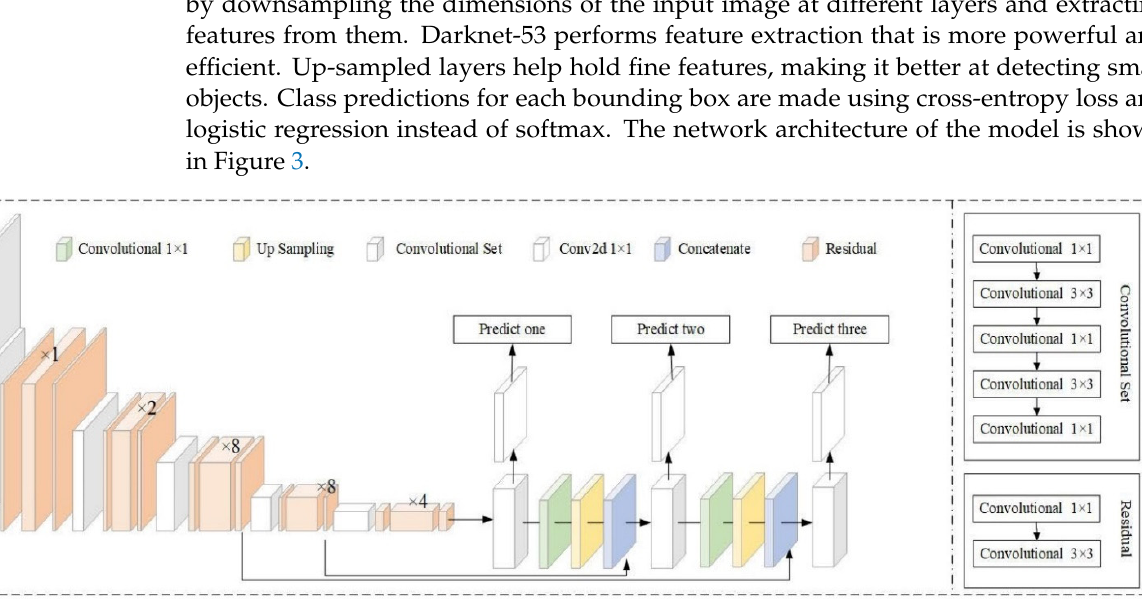
Figure 3. YOLOv3 network architecture that predicts at three scales [64].